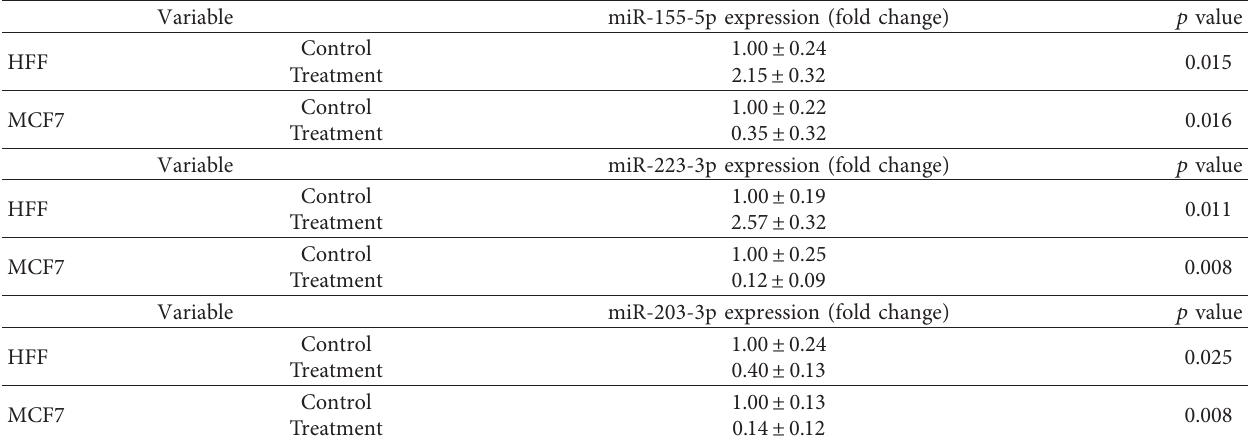
Table 4: The t -test was performed for the comparison of microRNA expression between control and treatment groups in the MCF7 and HFF cell lines.